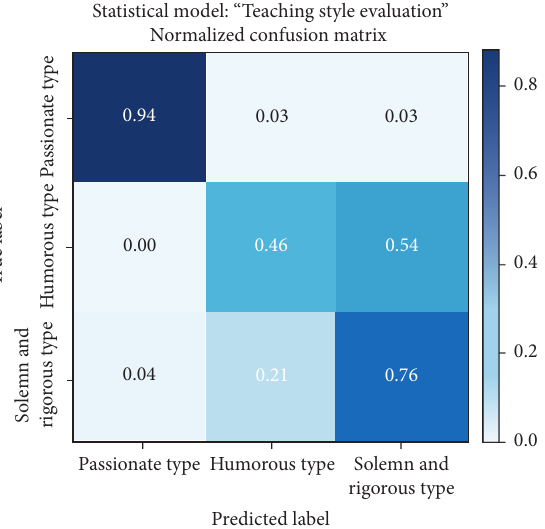
Figure 4: Integrated learning model: display of evaluation per- formance of “teaching type evaluation” indicators.